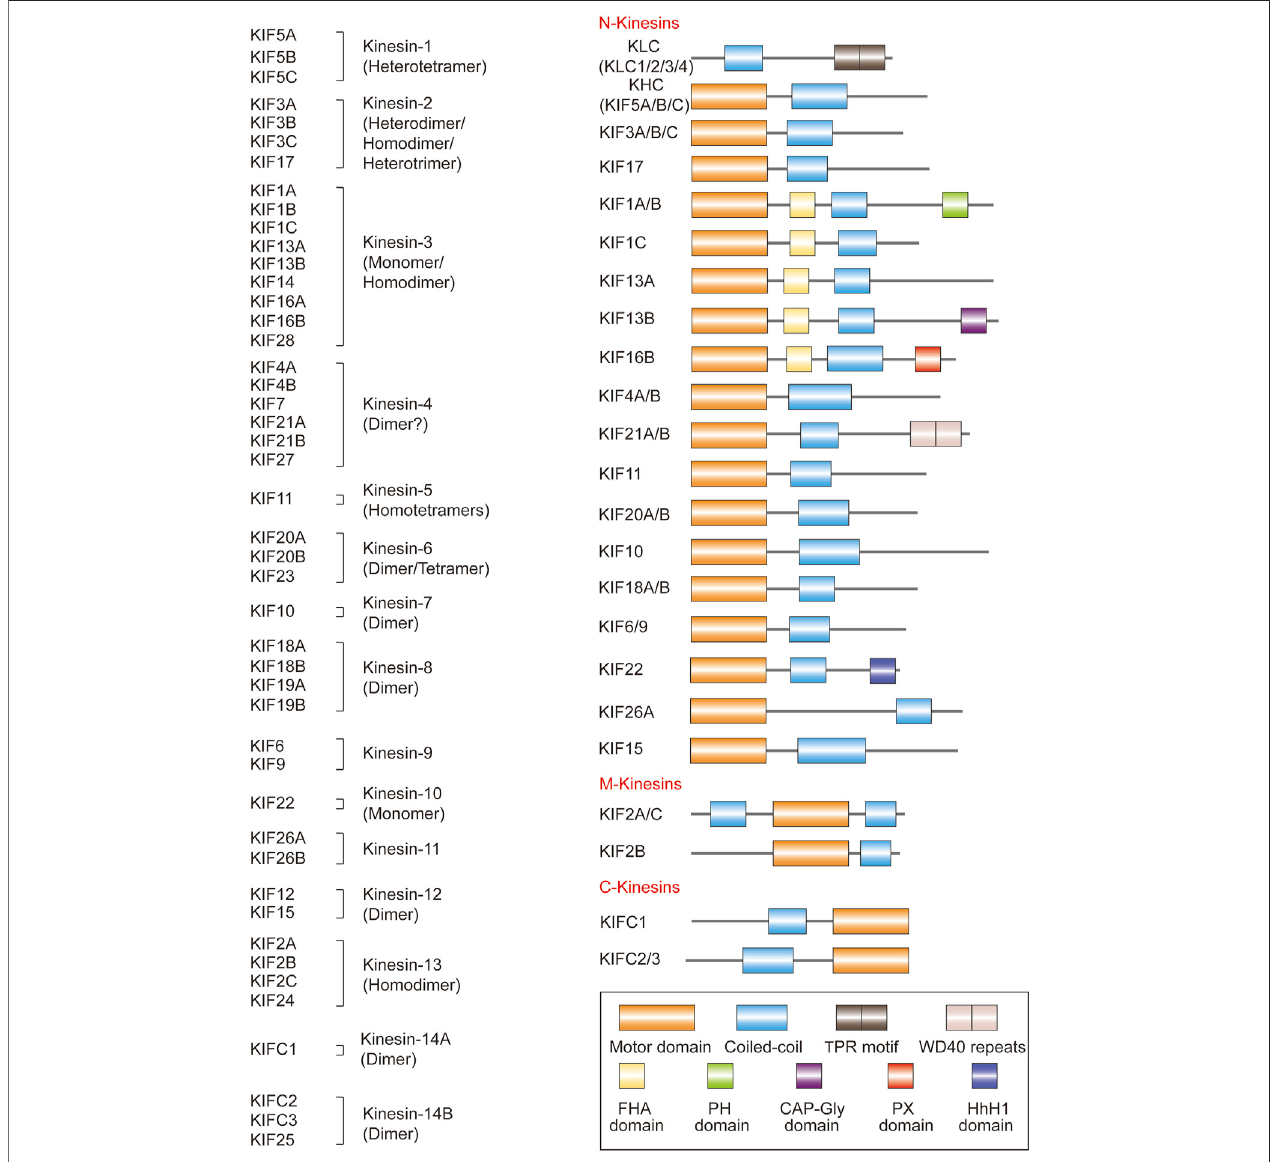
FIGURE 2 | The domain structure and classi fi cations of kinesins discovered in each of the human, mouse, and rat genomes (except that KIF16A and KIF19B are predictive in the rat). KIF11 is also known as KIF8 in the mouse, and KIF6 is also known as kinesin-related protein 3 (KRP3) in the rat. KIFC1 has isoforms KIFC4 and KIFC5 inthemouse. Kinesins shareacommonstructurebutalso havedomains thatareuniquetoeach KIFmember.KLC,kinesin lightchain;KHC, kinesinheavychain; TPR, tetratricopeptide repeat; WD40 repeats, protein interaction motifs of approximately 40 amino acids that usually terminate in tryptophan-aspartic acid (WD); FHA, forkhead associated; PH, Pleckstrin homology; CAP-Gly, cytoskeleton-associated protein glycine-rich; PX, PhoX homologous; HhH1, Helix-hairpin-Helix DNA- binding motif class 1.